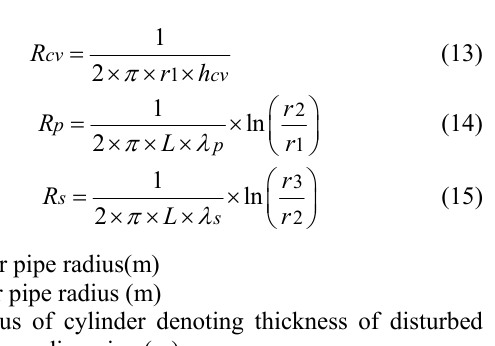
Figure 1. circulation of the air in the